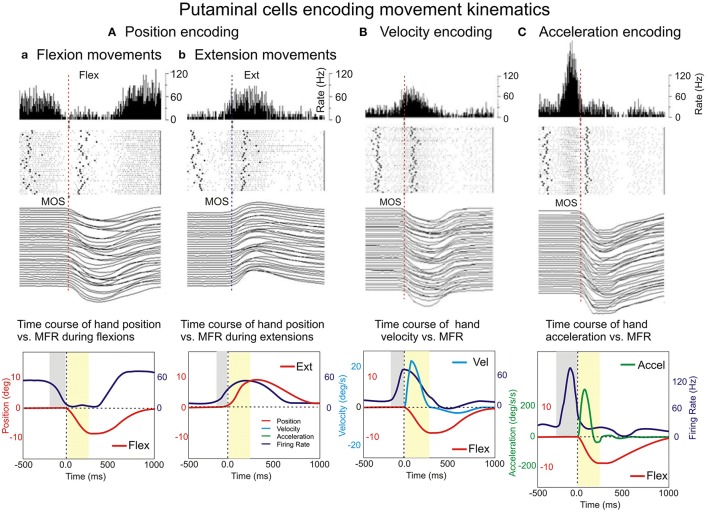
Examples of encoding the variables of movement kinematics. Putamen neurons show encoding of hand position (Aa, flexions and b, for extensions) movement velocity (B) and acceleration (C). Peri-event histograms (PEHs), rasters, and movement trajectories were plotted for R flexions and extensions (Aa,b), velocity (B), and acceleration (C). The PEHs of the neuronal activity expressed as mean firing rate (in spikes/s), with a bin size equal to 5 ms and a raster display. In the raster display, rows represent individual trials, dots represent single spikes, while the left and right bold dots represent vibratory cue onset and reward delivery, respectively.